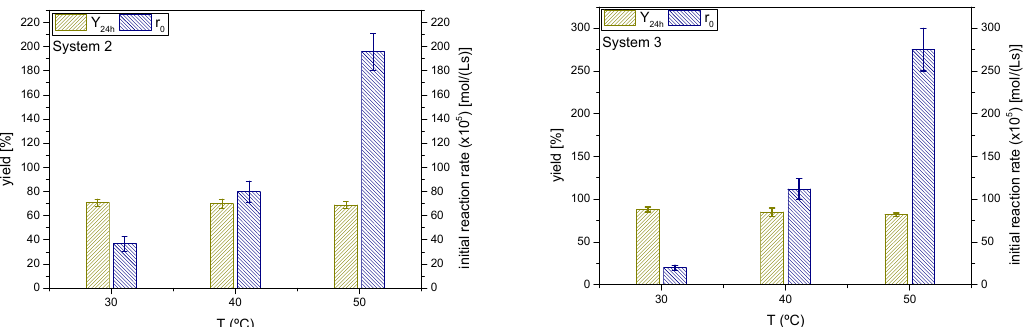
Figure 13. Influence of the reaction temperature on the yield of ketals 2 and 3 at 24 h and the initial reaction rate (Reaction conditions: butanone / glycerol or cyclohexanone:glycerol molar ratio, 6:1; temperature, 40 °C).